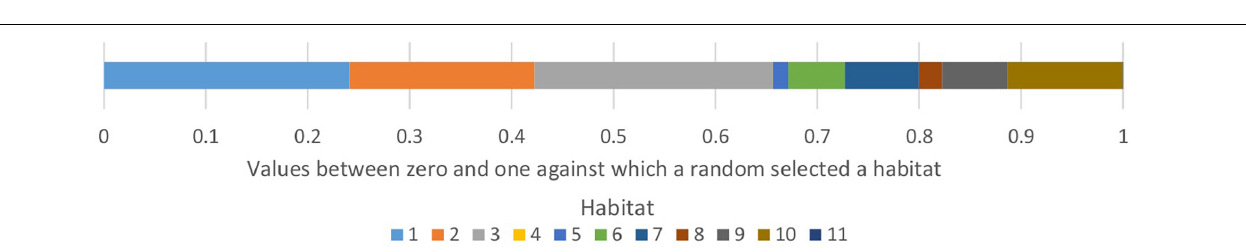
FIGURE 3 | A representation of how each individual chose where to move to in a time-step. It did this by multiplying the proportion of each habitat in a circle around it up to the maximum movement distance, by the bias multiplier. The values were normalized and stacked and then a random number between zero and one was drawn which selected the habitat. The individual then moved to a random cell of that habitat within the maximum movement